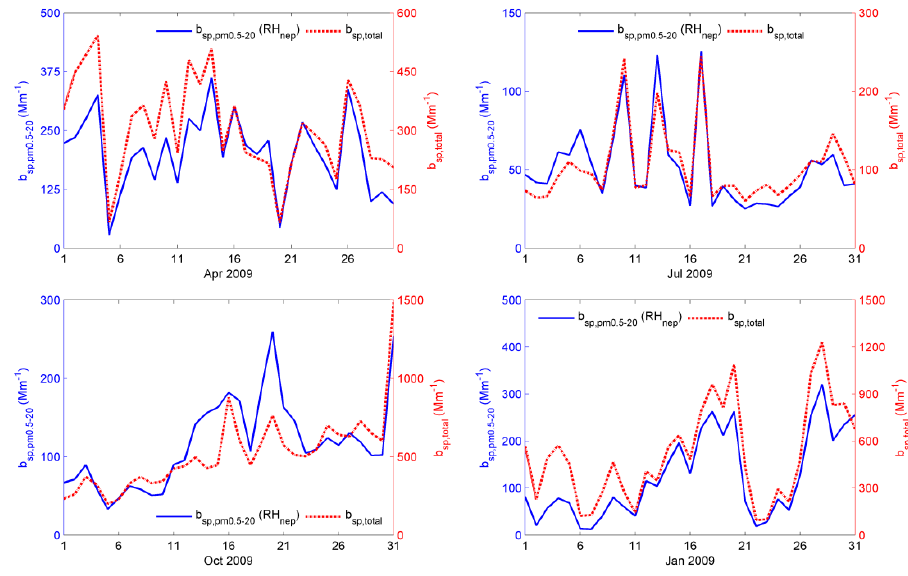
Figure 5 Comparison between variations of estimation and measurement 422 Fig. 5. Comparison between variations of estimation and measurement. 423 respectively. Figure 5 indicates a coherent temporal variation trend between the two data sets in April, July and January as correlation coefficient was 0.88, 0.92 and 0.94,